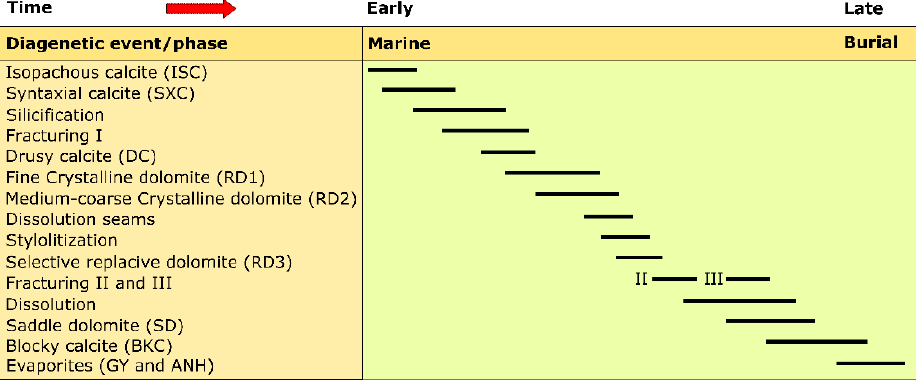
Figure 19. Paragenesis of Silurian formations (modified from Tortola [46]).